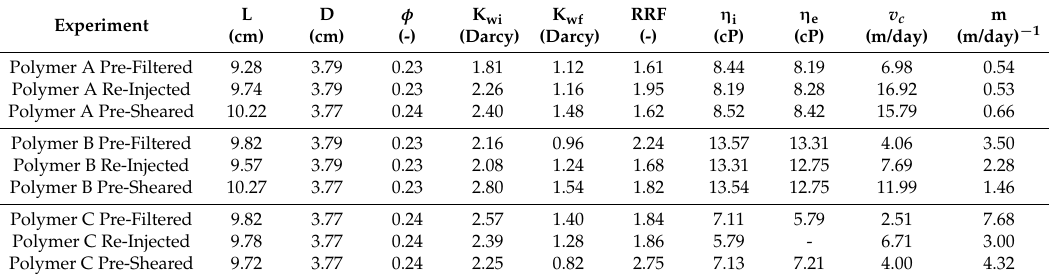
Table 4. Cores and viscoelastic properties of semi-dilute polymers at concentration of 1000 ppm for polymers A and B, and 500 ppm for polymer